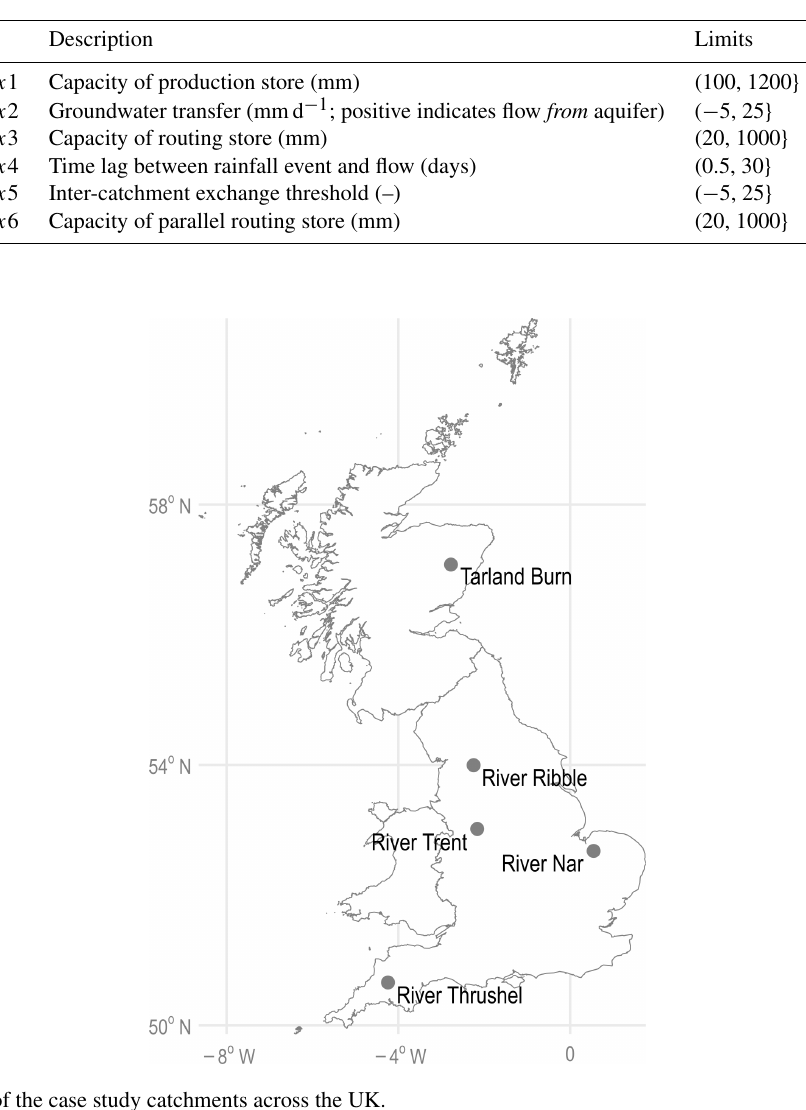
Table A1. Parameter limits for the hydrological models.